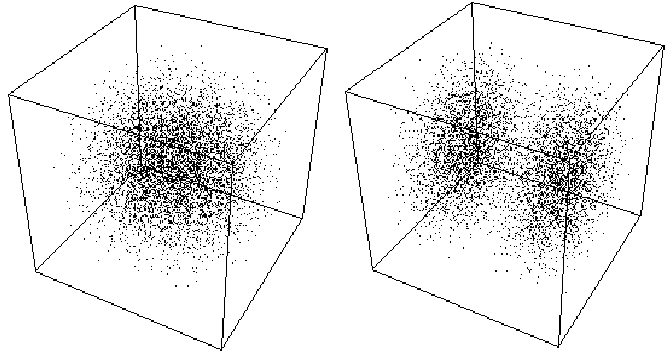
Figure 5. Model of duplication. The stationary solutions of the Schr ¨ odinger equation in a 3D box can take only discretized morphologies in correspondence with quantized values of the energy. An increase of energy results in a jump from a single structure to a binary structure. No stable solution can exist between the two